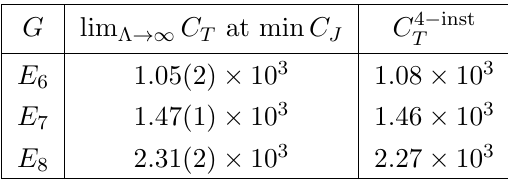
Table 8. The values of C T when the lower bound on C J is saturated for interacting theories with (cid:13)avor groups G = E 6 ; E 7 ; E 8 , and compared to the four-instanton values in the rank-one Seiberg exceptional theories.